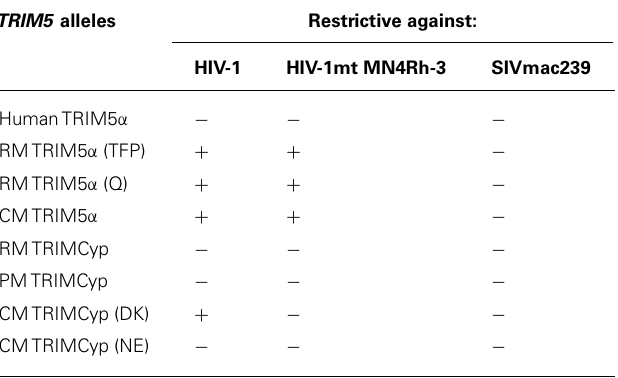
Summary of findings about interactions between each TRIM5 allele and lentiviruses (Stremlau etal., 2004; Newman etal., 2006; Liao etal., 2007; Bren- nan etal., 2008; Virgen etal., 2008; Dietrich etal., 2011; Saito etal., 2012b). “ + ” denotes restrictive, while “ − ” denotes not restrictive against each lentivirus,